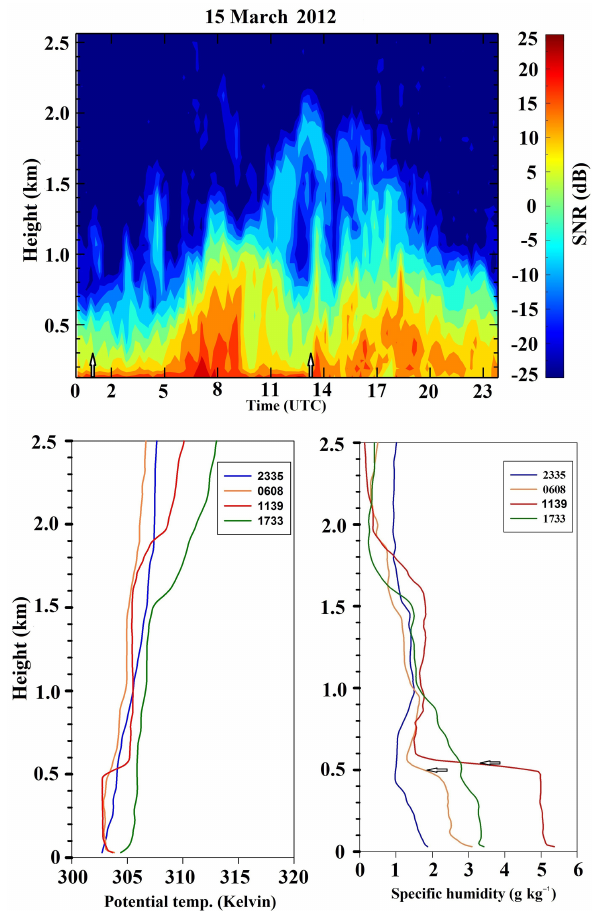
Figure 4. Same as Fig. 3 but for 15 March